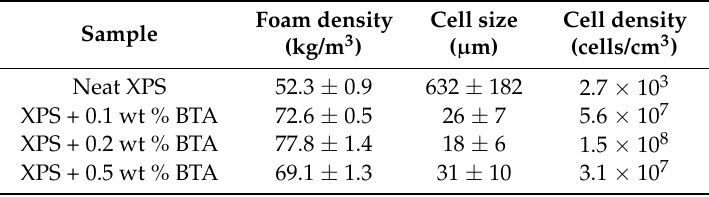
Table 1. Density and morphological properties of extruded polystyrene (XPS)